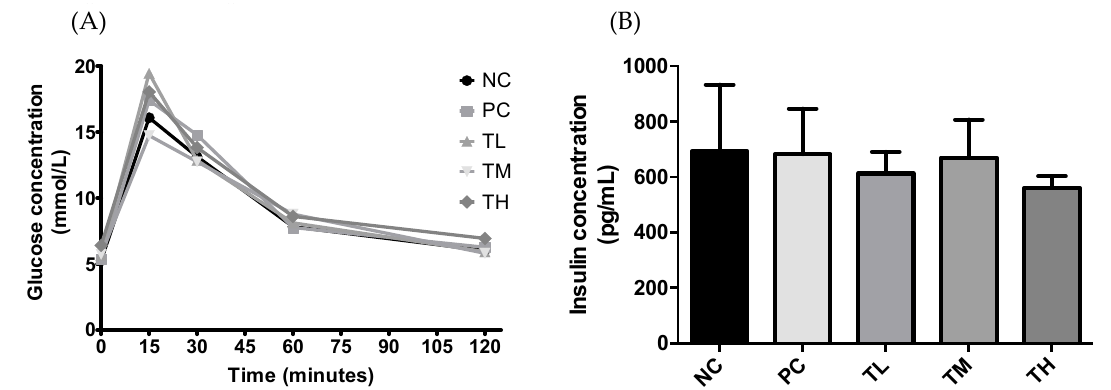
Figure 8. Effect of IMD on blood glucose levels (A) and insulin concentration (B) in the plasma of mice with LPS-induced chronic inflammation, as measured by ELISA. Results are expressed as means ± SEM.